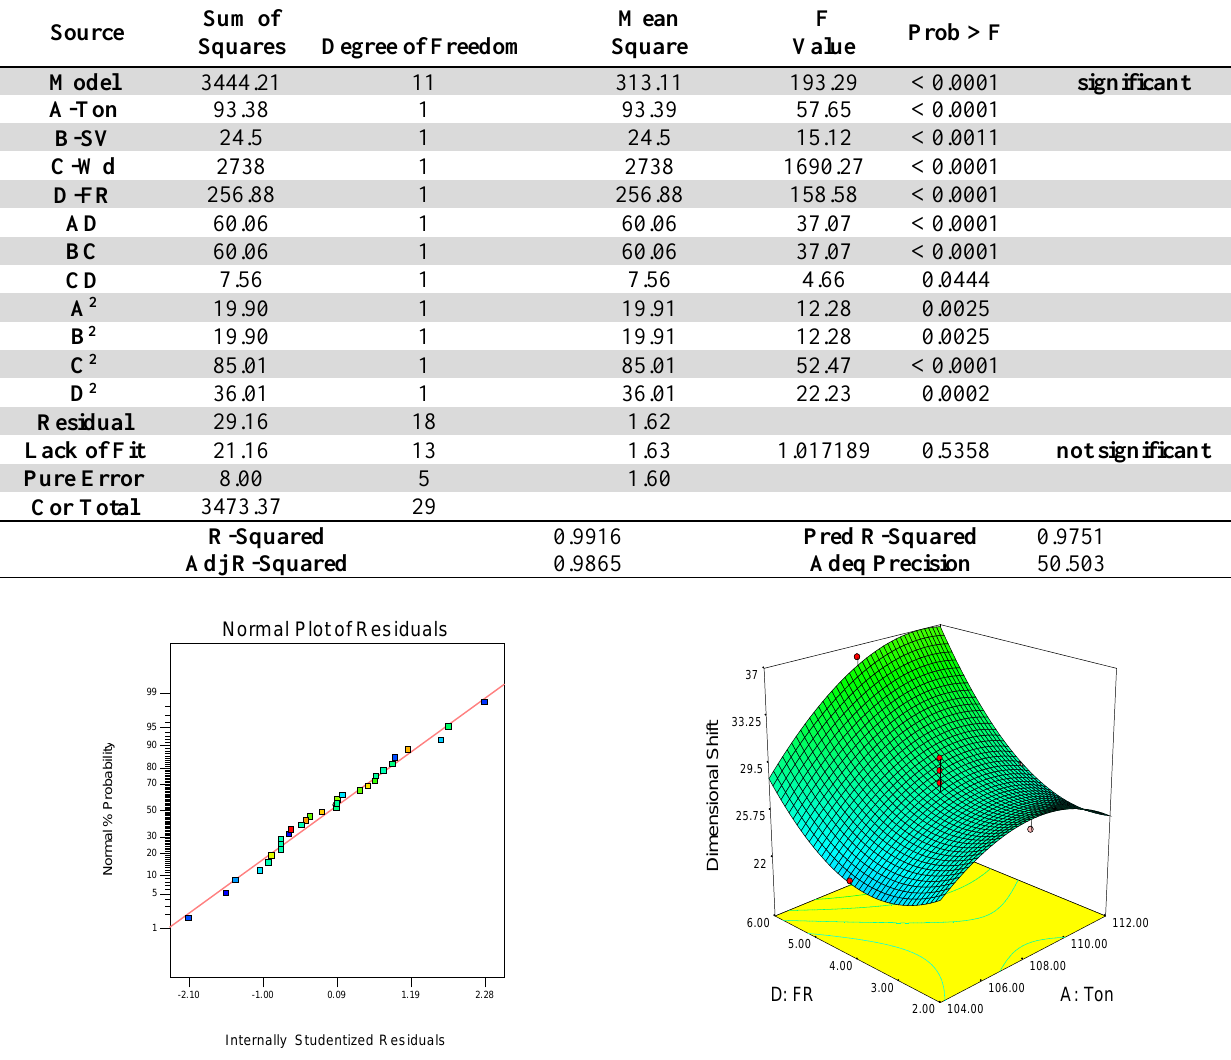
Fig. 7. Residuals plot for SR Fig. 8a. Combined effect of FR and Ton on D S